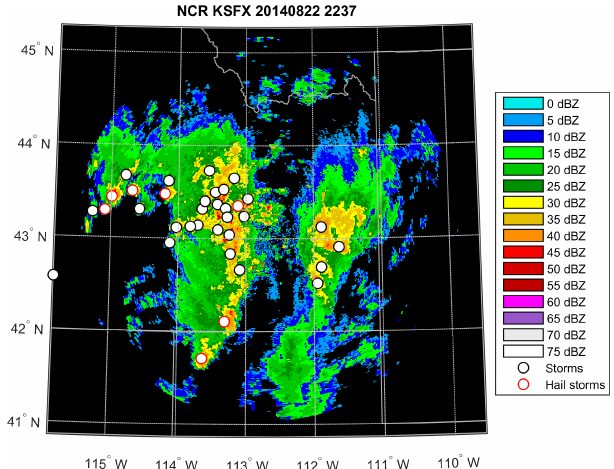
Figure 2. Example of a single 5min period of radar data from KSFX (ID; 8 August 2013, 22:37UTC). The colors show the com- posite reflectivity (i.e., the maximum reflectivity from any of the elevation angles sampled by the NWS radar) in decibel reflectiv- ity (dBZ). The circles represent storm cells that are identified and tracked by the NWS detection algorithm; black circles are storms without hail, and red circles are those with